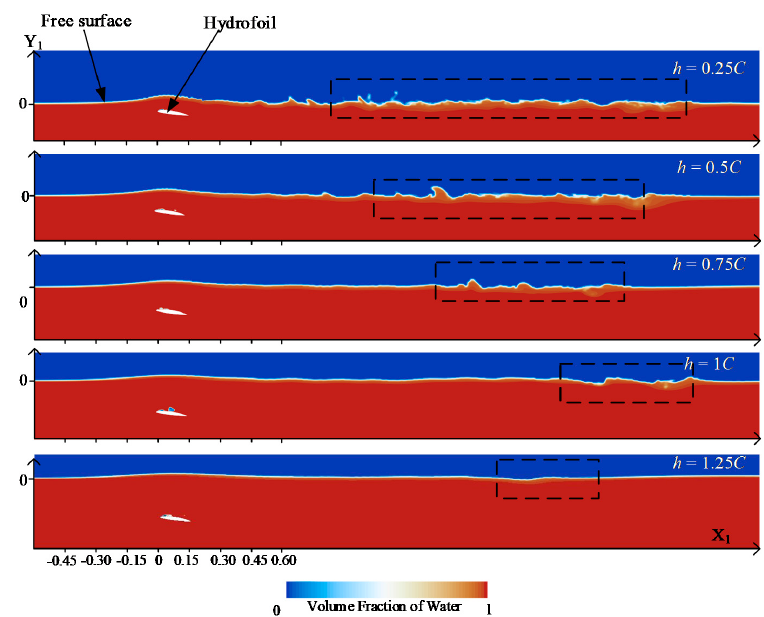
Figure 20. Volume fraction of water on the mid-section plane for di ff erent depths at the same cavitation cycle